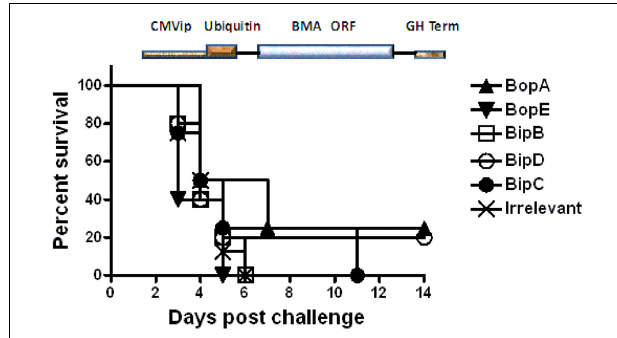
FIGURE 1 |Validation of ORF construction and expression in vivo . A set of five genes encoding B. mallei proteins predicted to be secreted were generated and constructed as linear expression elements (LEEs).These LEEs were constructed by the same protocols as intended for use in preparing and testing the B. mallei ORF library for vaccine candidates. Inset cartoon shows LEE design.These five LEEs were co-delivered with LEEs encoding the E. coli heat-labile enterotoxin subunits A and B (LTA/B) as adjuvant by gene gun at weeks 0, 3, and 6 into groups of five mice. At week 9, mice were evaluated immunologically in challenge–protection assays. Survival curves of immunized animals are plotted following i.n. delivery